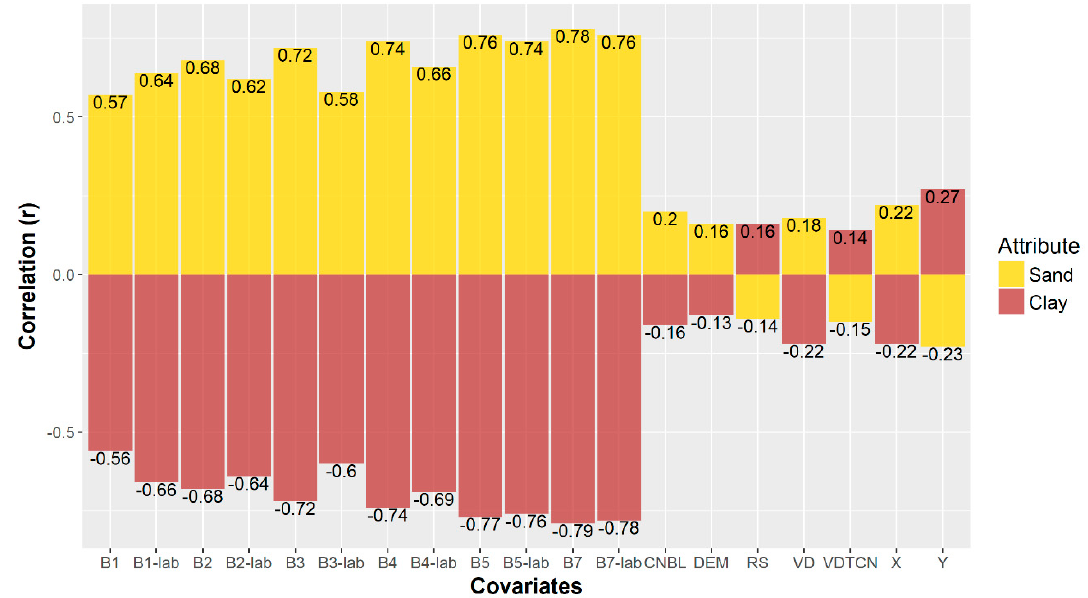
Figure 8. Pearson’s correlation between covariates and clay and sand contents. RDC: relief-derived covariates; DEM: digital elevation model; CNBL: distance from channel network to base level; RS: relative slope; VD: valley depth; VDTCN: vertical distance to channel network; X: Easting coordinate; Y: Northing coordinate. B1 to B7: spectral reflectance from the Synthetic Soil Image (SYSI) bands with the Landsat 5 TM spectral ranges. The suffix “lab” indicates the laboratory spectra convolved to Landsat 5 TM spectral bands.